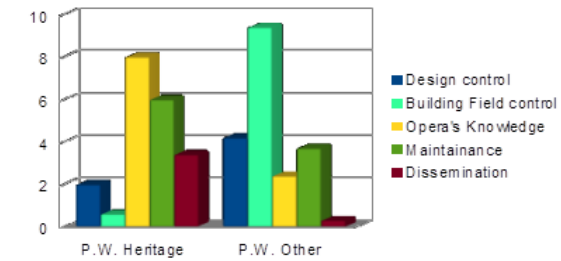
Figure 5 . Reasons, indicated in percentages, for use BIM in public and private works (Figure by P. Fiamma).